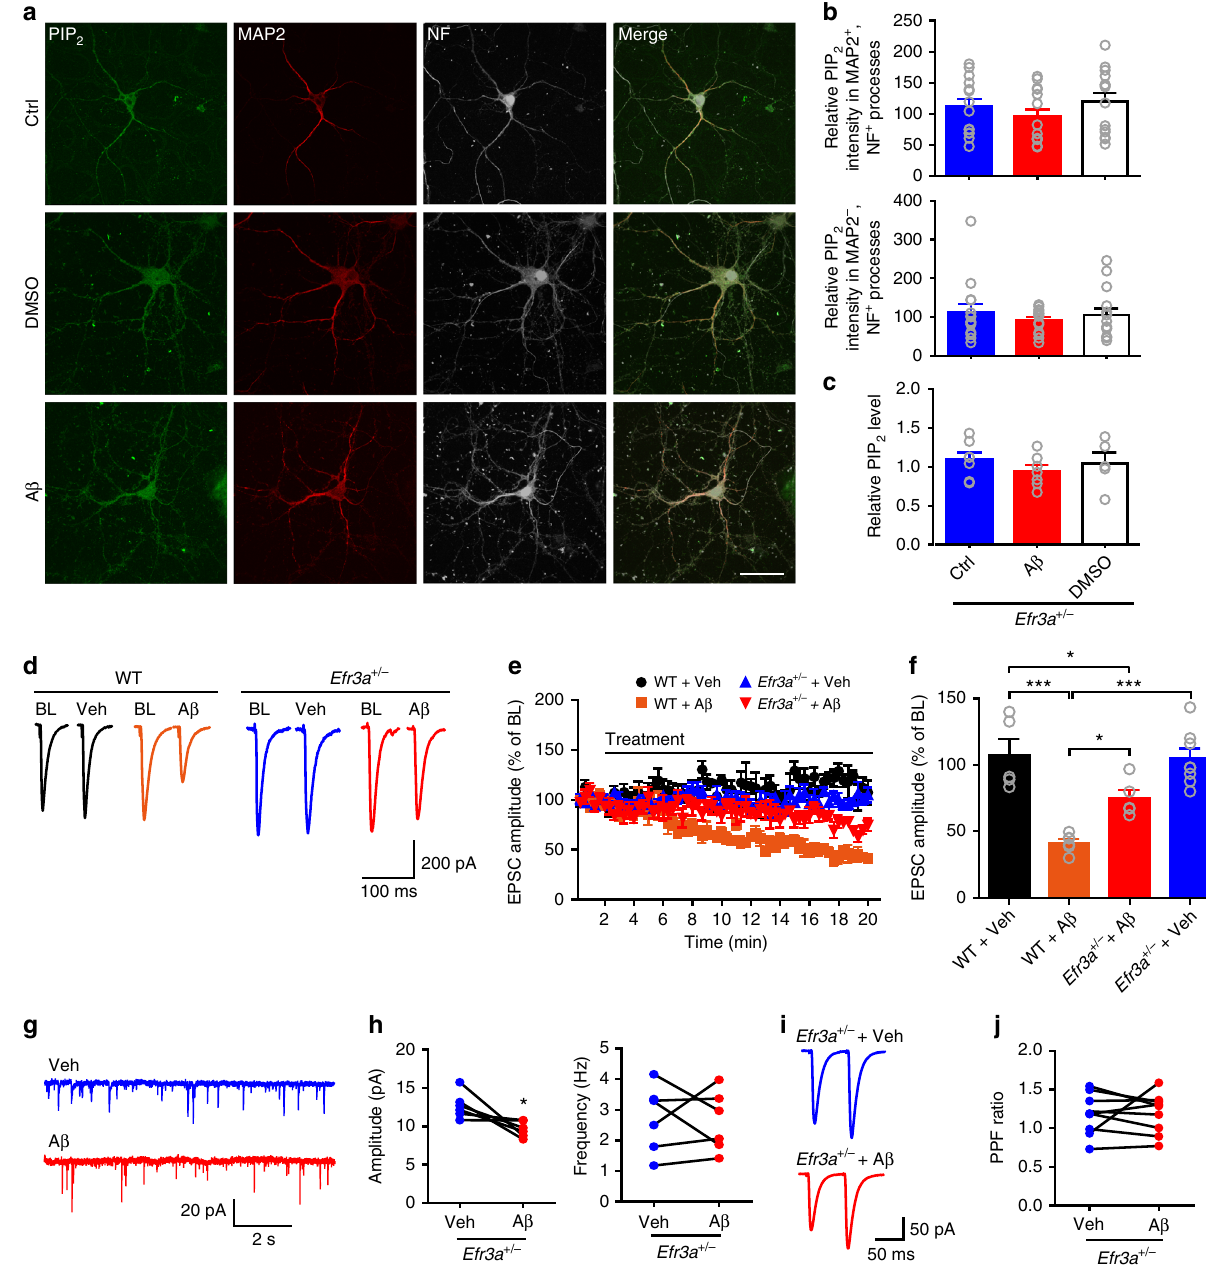
Fig. 7 Oligomeric A β -induced PIP 2 reduction and presynaptic de fi cit are rescued by knocking down Efr3a . a Confocal images showing the effect of oligomeric A β on PIP 2 levels in neuronal processes in primary hippocampal neurons from Efr3a + / − mice. Bar, 50 μ m. b Quanti fi cation of relative PIP 2 intensity in dendrites (upper panel) and axons (bottom panel) showing knocking down Efr3a prevents A β -induced suppression of PIP 2 in neurites. One-way ANOVA with post hoc Dunnett ’ s test; F (2,39) = 0.98 (upper); F (2,49) = 0.44 (bottom); P > 0.05; N = 14 per group. c Quantitative results showing knocking down Efr3a prevents A β -induced suppression of PIP 2 in cultured hippocampal neurons (measured by PIP 2 ELISA). One-way ANOVA with post hoc Dunnett ’ s test; F (2,16) = 0.66; P > 0.05; N = 5 – 7 per group. d , e Representative traces ( d ) and the time course of normalized amplitude ( e ) of SC-CA1 EPSCs in WT and Efr3a + / − hippocampal slices before (BL) and after drug treatment (Veh or A β ). f Bar graph representing the relative magnitude of EPSCs recorded in the last 1 min of drug treatment shown in e . One-way ANOVA with post hoc Dunnett ’ s test; F (3,23) = 16.88; * P < 0.05; *** P < 0.001; N = 5 – 8 per group. g , h Representative traces ( g ) and quanti fi cation ( h ) of mean values of the amplitude (left) and frequency (right) of mEPSCs in CA1 pyramidal neurons in Efr3a + / − mice showing oligomeric A β treatment no longer inhibits mEPSC frequency. t test; * P < 0.05; N = 6 per group. i , j Representative traces ( i ) and quanti fi cation ( j ) of PPF of SC-CA1 EPSCs showing oligomeric A β does not alter PPF ratio in Efr3a + / − mice. t test ; P > 0.05; N = 9 per group. Data are mean ± SEM. Source data are provided as a Source Data fi